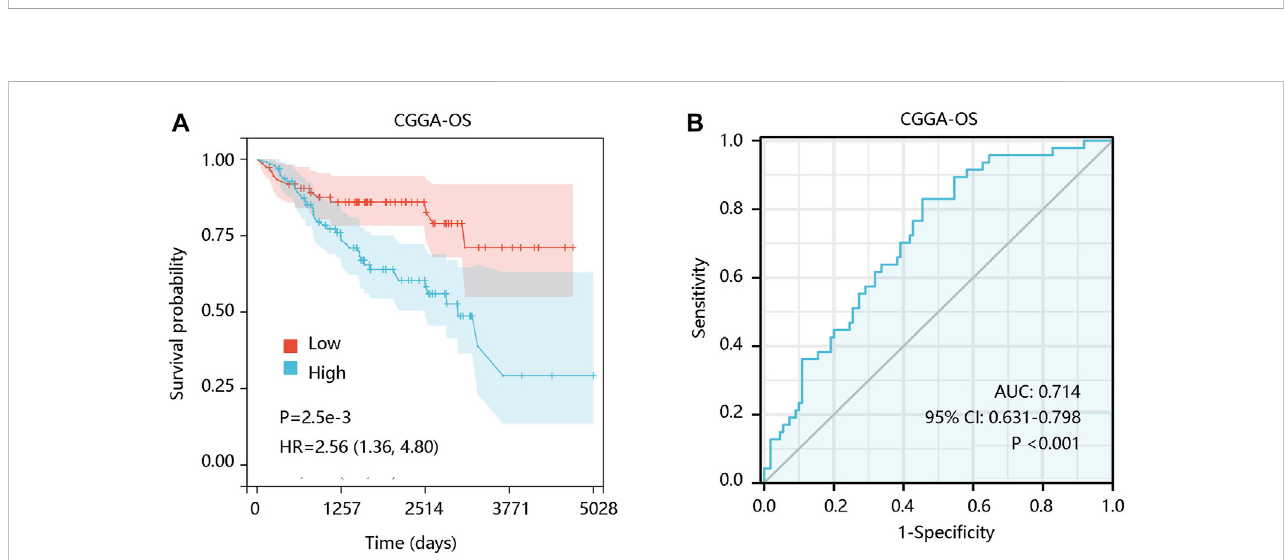
FIGURE 4 The prognostic value of ALOX5 gene in CGGA-LGG data. (A) Patients with high ALOX5 gene expression had poor OS. (B) ALOX5 expression presented satisfactory performance in predicting the OS status. OS, overall survival; AUC, area under the curve; 95% CI, 95% con fi dence interval; HR, hazard ratio.